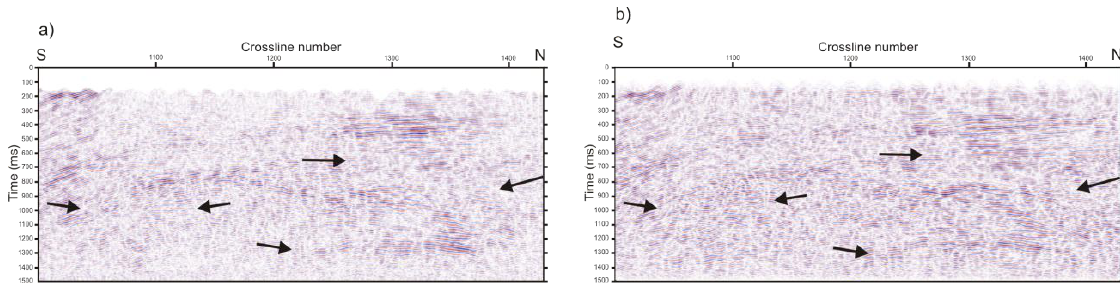
FIG. 10: Unmigrated seismic section from inline 1231 with (a) up to processing step 14 (Table 2) applied, and (b) same as (a) with DMO corrections applied. Note the enhancement of coherency after the application of the DMO (black arrows). The location of inline 1231 is marked in Fig. 2.